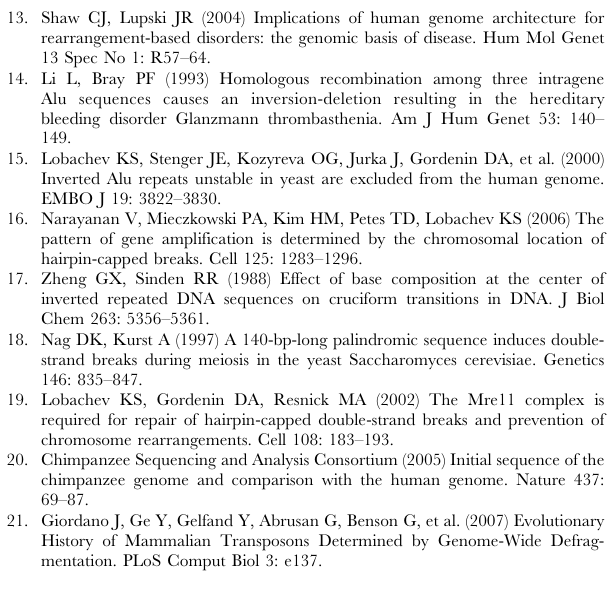
Table S1 Genomic positions of RRMI loci between human and chimpanzee lineages